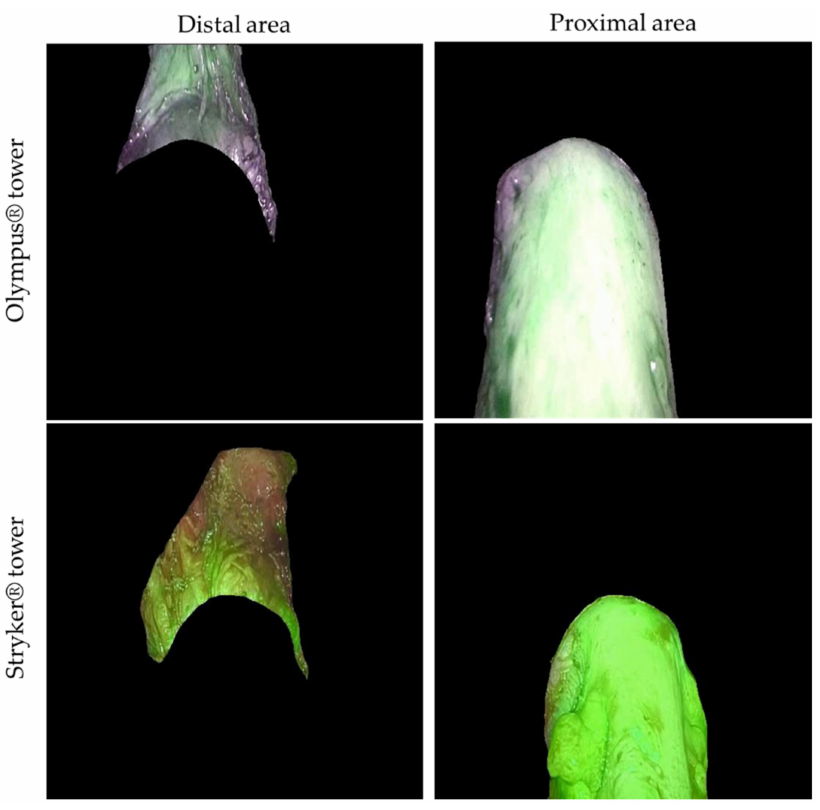
Figure 4. Example of the automatic segmentation, produced with the best model, of the intestine’s proximal and distal areas using the Olympus ® and the Stryker ®